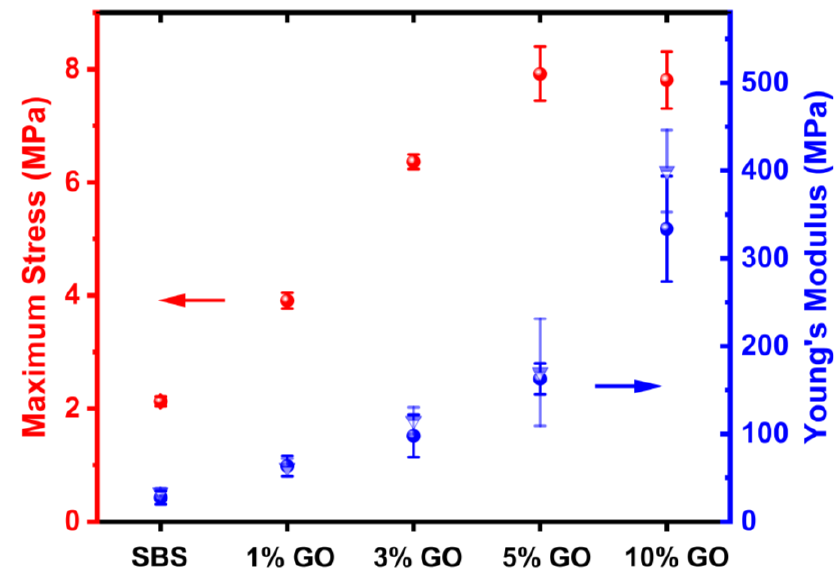
Figure 10. Maximum stress and Young’s modulus values for the SBS composites according to tensile measurements (solid sphere symbols) and nanoindentation measurements (triangle symbols).